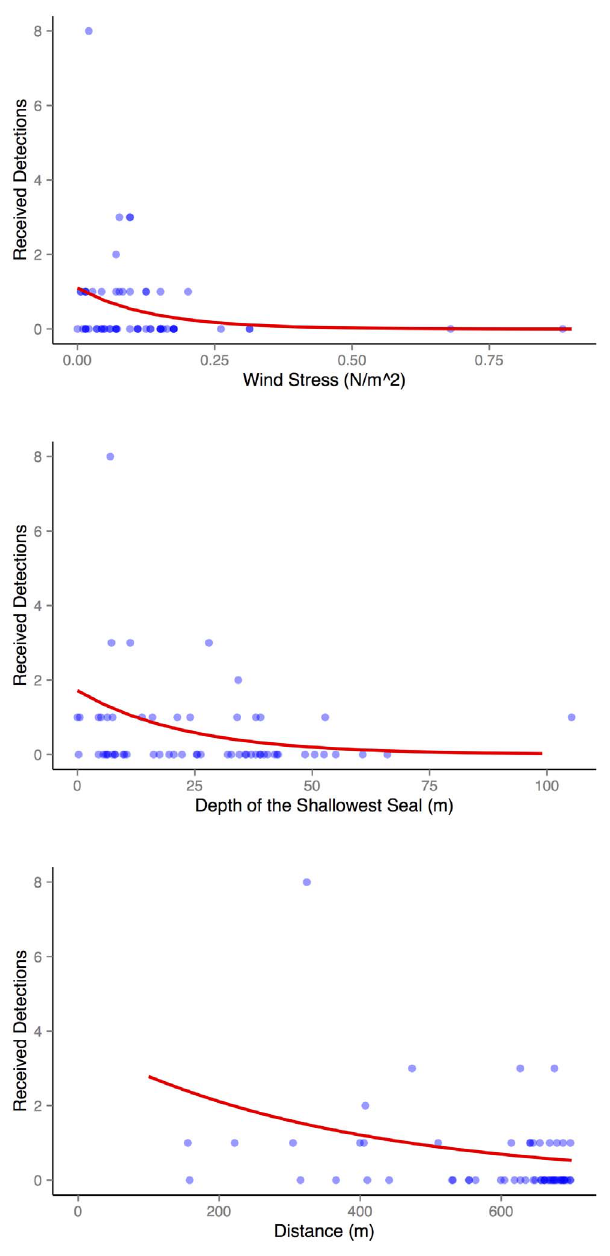
Figure 5. Factors affecting detection efficiency. The predicted effect on detection efficiency of the significant variables (red line): wind stress, minimum depth, and distance. Fitted values (observed detec- tions offset by expected detections) as points. Points: dark blue indicates high intensity, light blue indicates low intensity. doi:10.1371/journal.pone.0098117.g005 To date, GPS tags provide the best location estimates for in situ studies of this nature. GPS locations were obtained with a small residual error ( v 15 m) [32], resulting in little uncertainty in the GPS locations and subsequently, little uncertainty in the actual detection distances observed. Therefore, although it is possible for the seals to be 60 m closer or further away than that reported, the chance of this occurring are low.